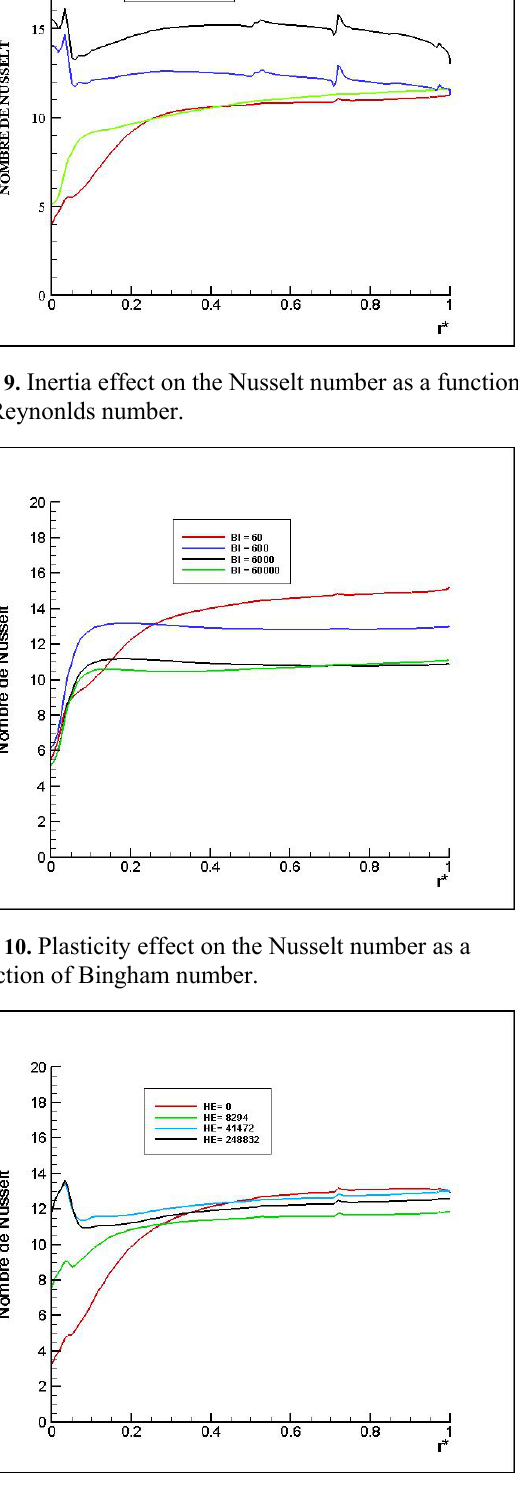
Fig. 11. Effect of Hedstrom number on the Nusselt number for different radious